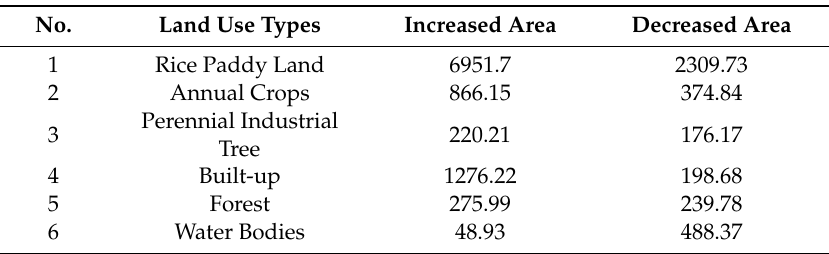
Table 7. The spatiotemporal changes in EDSI area (km 2 ) by types of land use in the 2000–2018 period.